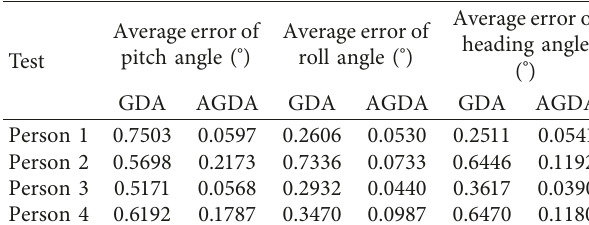
Table 3: Average error of attitude angle in test